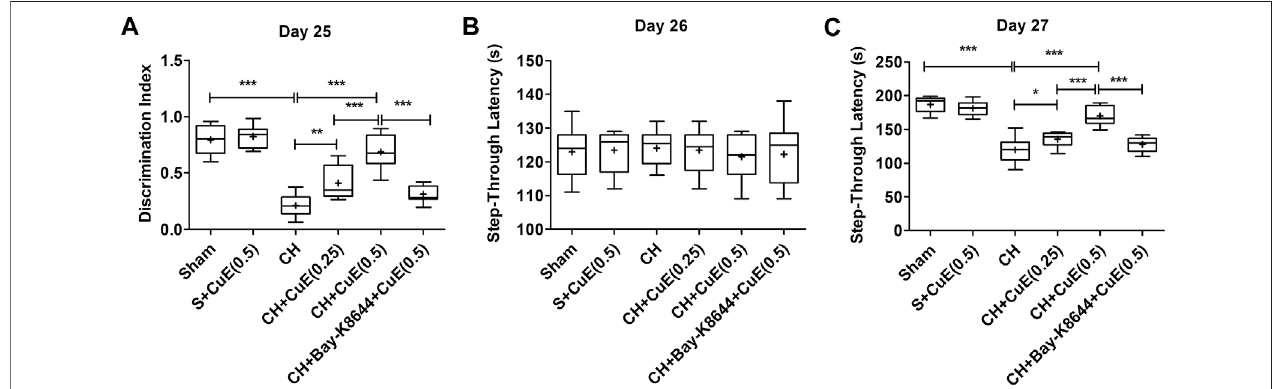
FIGURE 2 | Post-treatment with CuE, 0.25 and 0.5 mg/kg, p.o. , decreased CH-induced loss of memory in rats. In a novel object recognition task, animalstreated with CuE exhibited increase in discrimination index (A) . STL (s) during acquisition trials in PA tests showed no signi fi cant difference (B) , CuE signi fi cantly decreased retention trial STL (C) . Bay-K8644 signi fi cantly attenuated increase in DI and STL by CuE. Box and whisker plots (Tukey) show mean (+), median (bold horizontal line), quartiles (box), and total range (whisker) ( n (cid:1) 12). *( p < .05), ** ( p < .01), *** ( p <